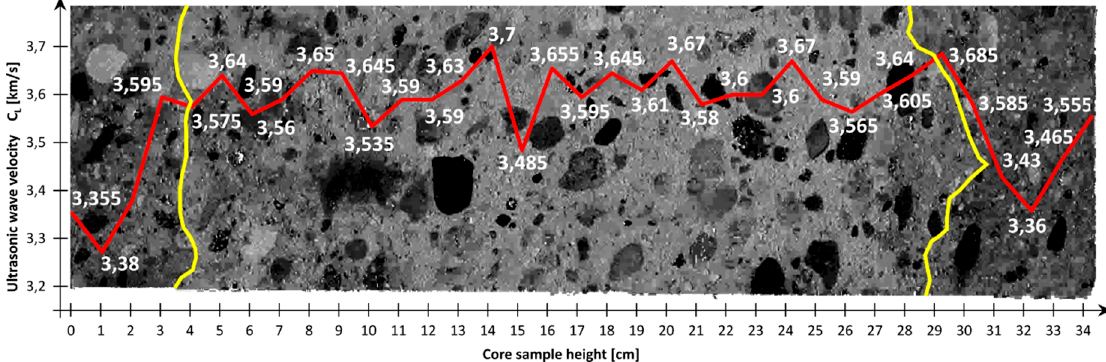
Figure 5. The structure of concrete of the sample taken perpendicularly to the top surface of the slab (slab top surface on left). The image also shows distribution of the mean velocity C L of longitudinal ultrasonic wave (red line) and disturbance zone at the top and bottom surface of the slab (yellow line).